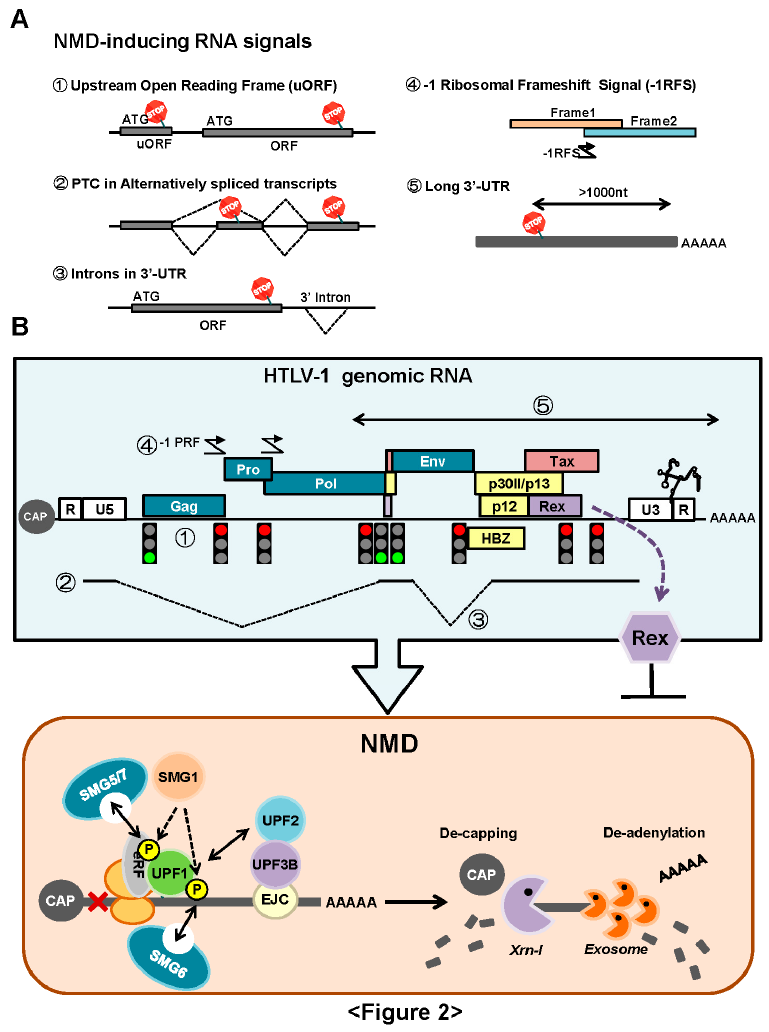
Figure 2. ( A ) NMD is an essential and evolutionarily-conserved cellular mRNA quality control mechanism. The principal function of NMD is to prevent the expression of harmful truncated proteins by selective elimination of aberrant mRNAs containing premature termination codons (PTCs). It has been reported that NMD also regulates the expression levels of normal mRNAs, which inherently contain RNA signals to generate PTC: 1. Upstream (U)-ORF, 2. alternative splicing producing PTC, 3. intron in 3 1 -UTR, 4. -1 programmed ribosomal frameshift signal (-1PRF) and 5. long 3 1 -UTR more than 1000 nt; ( B ) The genomic RNA of HTLV-1 contains various RNA signals potentially initiate NMD, i.e. , 1. multiple start and stop codons, 2. two alternative splicing sites, 3. intron in the 3 1 -UTR region of gag/pro/pol mRNA, 4. overlapping ORFs, and -1 PRF and 5. a long 3 1 -UTR (>1000 nt). We reported that HTLV-1 genomic RNA was indeed destabilized by NMD, and HTLV-1 Rex had a new function to inhibit NMD